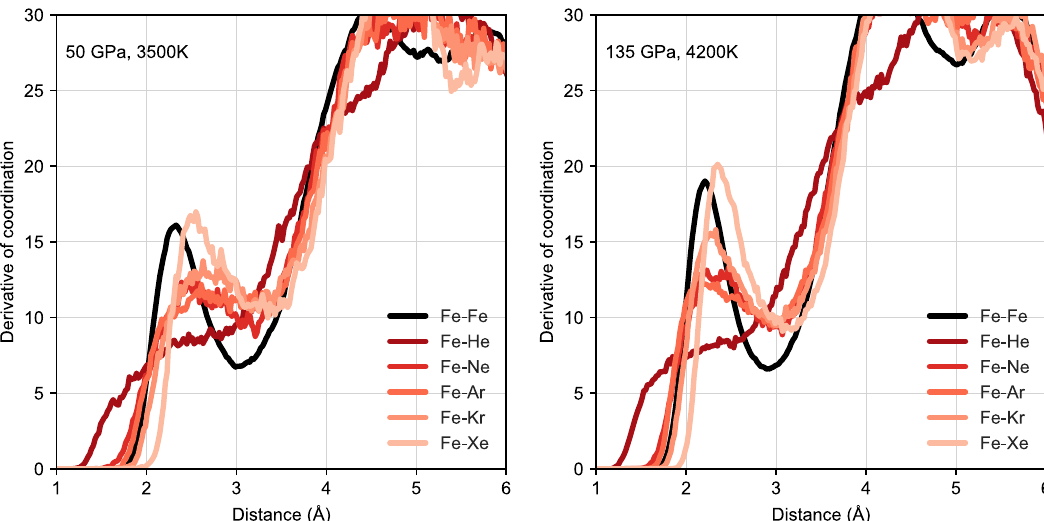
Fig. 5 Derivative of coordination numbers for noble gas containing liquid iron. The fi rst-order derivatives of Fe coordination numbers for coordination numbers shown in Fig.